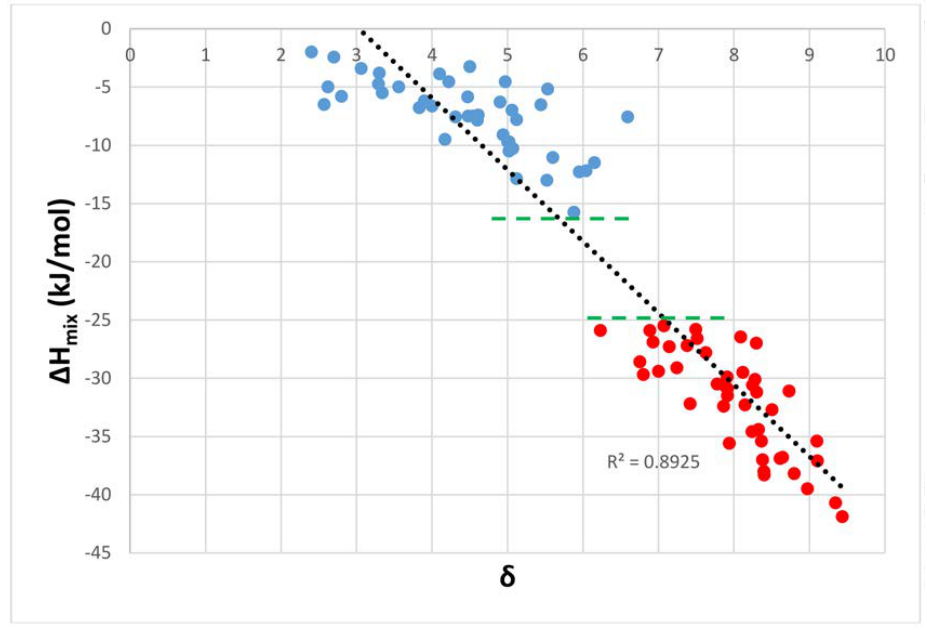
Figure 3. ∆ H mix versus δ of Nb ss (filled blue circles) and of eutectics with Nb ss and Nb 5 Si 3 (filled red circles) in Nb-silicide based alloys. All of the data linear fit with R 2 =